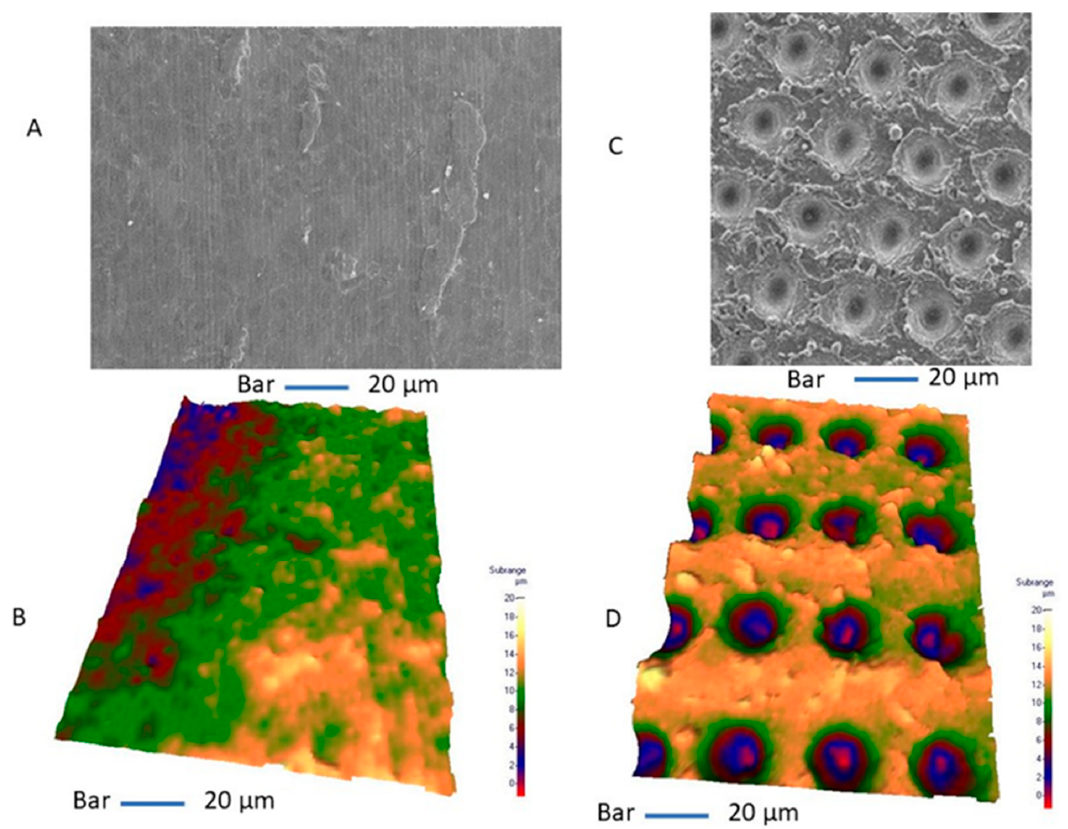
Figure 6. Conventional SEM image transformed into three-dimensional data for evaluation of surface roughness. ( A , B ) Machined implant. ( C , D ) Lasered implant. The laser treatment produces a macro-concavity with a size of 20 µ m diameter with 30 µ m pitch and a hemispheric pore depth of 5 µ m.